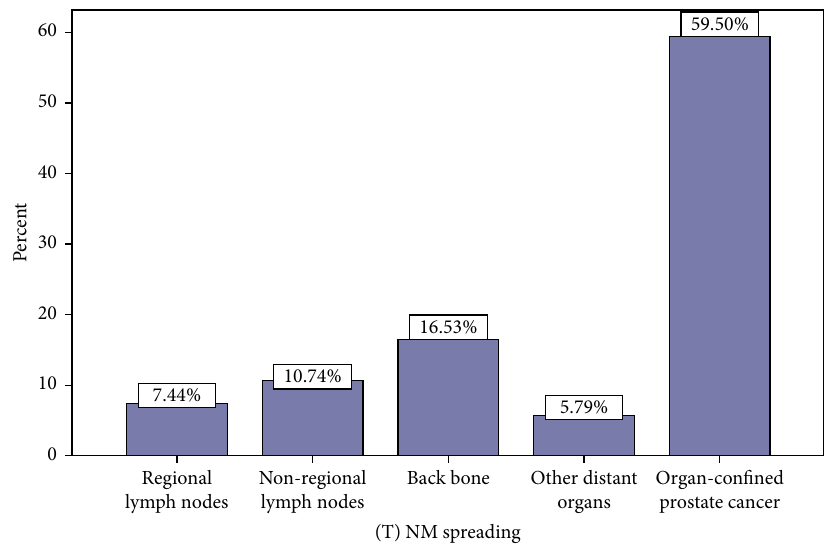
Figure 1: Spreading of prostate cancer in the patients. Back bone was the most distant organ involved by the spreading